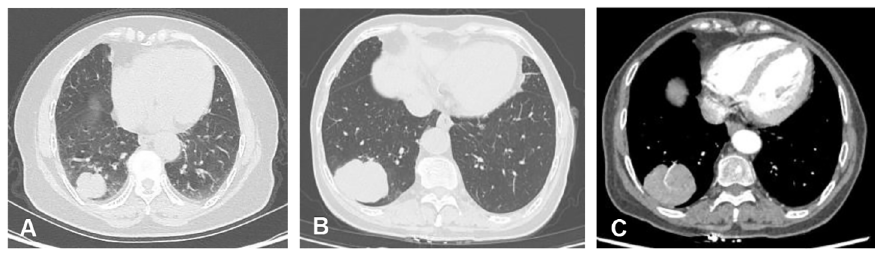
Fig. 1 The chest CT scan manifestation of the tumor. A, In 2018, the tumor was well circumscribed, lobulated, and the maximum diameter was 3.7 cm. B, In 2021, the maximum diameter of the mass was 5.5 cm, with more obvious lobulation. C, Blood vessel was visible in the arterial phase of the